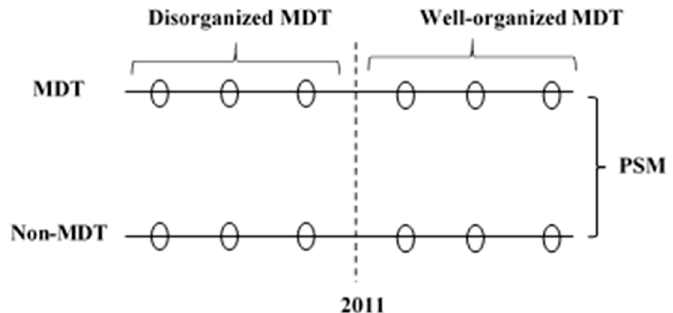
Figure 2. The study design. MDT: Multidisciplinary teams; N-MDT: without multidisciplinary teams’ treatment; PSM: propensity score matching.